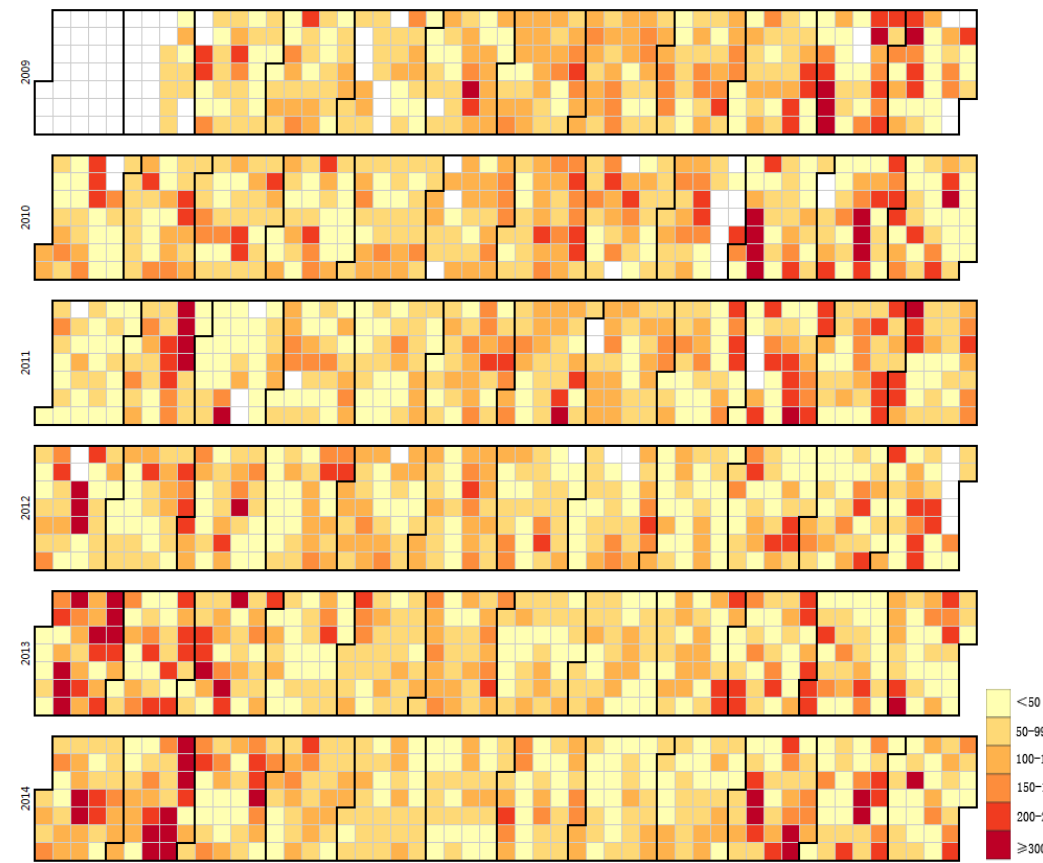
Figure 9. Circular heat maps from 2010 to 2014 are selected: ( a ) year and month circular heat map showing the monthly air pollution concentration; and ( b ) year and hour circular heat map showing the daily air pollution concentration.